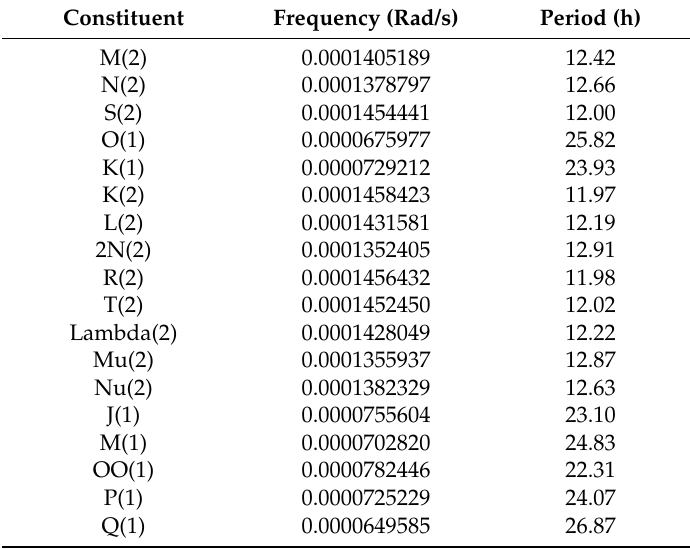
Table D1. Frequencies and periods for EC2015 harmonic